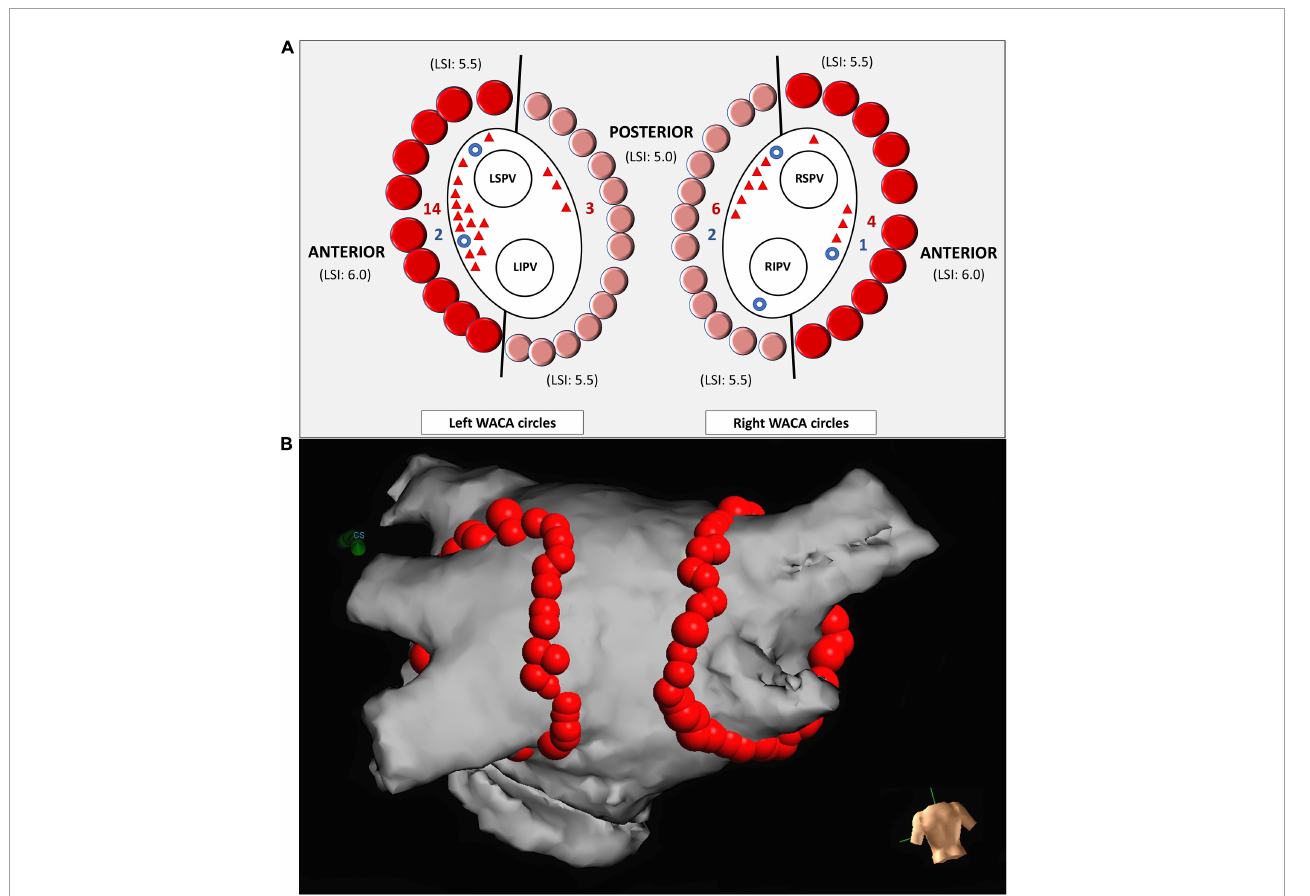
FIGURE1 Schema representing ipsilateral PV isolation by left and right WACA circles and the sites of reconnections (A) . Each WACA circle was anatomically divided into the anterior segment (dark red dots) and the posterior segment (light red dots). The point-to-point LSI-guided ablation of the anterior segment was performed with target LSI from 5.5 (superior region of WACA) to 6.0 (anterior region of WACA). Ablation of the posterior segment was performed with target LSI from 5.0 (posterior region of WACA) to 5.5 (inferior region of WACA). The sites of the acute and the late WACA segment reconnections are illustrated by blue circles and red triangles, respectively. The posterior view of the left atrium (B) . The lesion tags were annotated automatedly by the AutoMark software of the Ensite Precision mapping system, as the 3D red balls. The tag size was 5 mm in diameter for lesions reaching LSI 5.0-5.5, and 6 mm for those with LSI > 5.5. LSI, lesion size index; LSPV, left superior pulmonary vein; LIPV, left inferior pulmonary vein; RSPV, right superior pulmonary vein; RIPV, right inferior pulmonary vein; WACA, wide antral circumferential